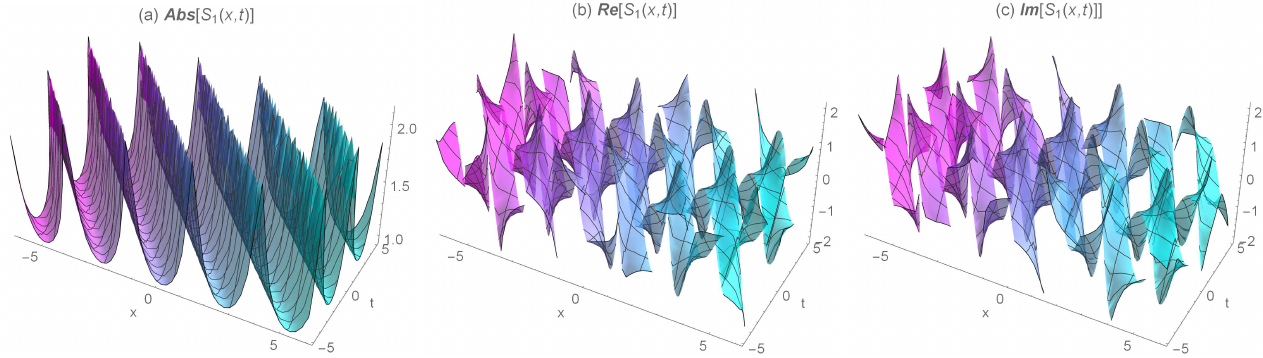
Figure 3. The 3D wave profiles for the absolute, real, and imaginary values of the periodic soliton solution for b = 0.9, c = 0.3, s = 1.5, k = 1, ϑ 0 = 0.2, ε 1 = ε 2 = 1, ε 3 = 1.2, Ω =